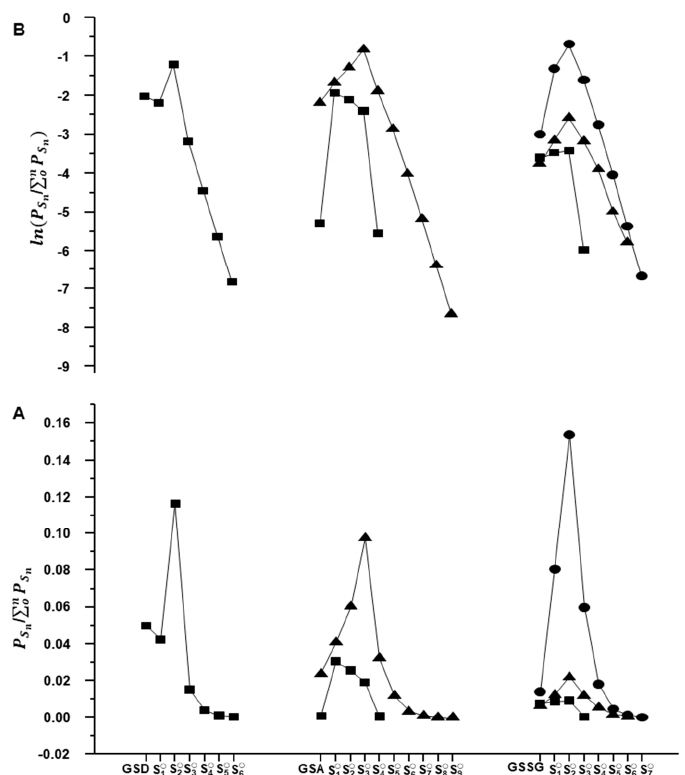
Figure 9. Relative distributions ( A ) and natural logarithm of relative distributions ( B ) of DH trapped GSS n D, acetamide trapped GSS n A, and oxidized GSS n G species determined from reactions of GSNO (1 mM) with Na 2 S (1 mM): (Squares) in the presence of DH (50 mM) and IA (50 mM); (triangles) in the presence of IA only; (circles) in the absence of DH and IA in iP buffer at pH 7.